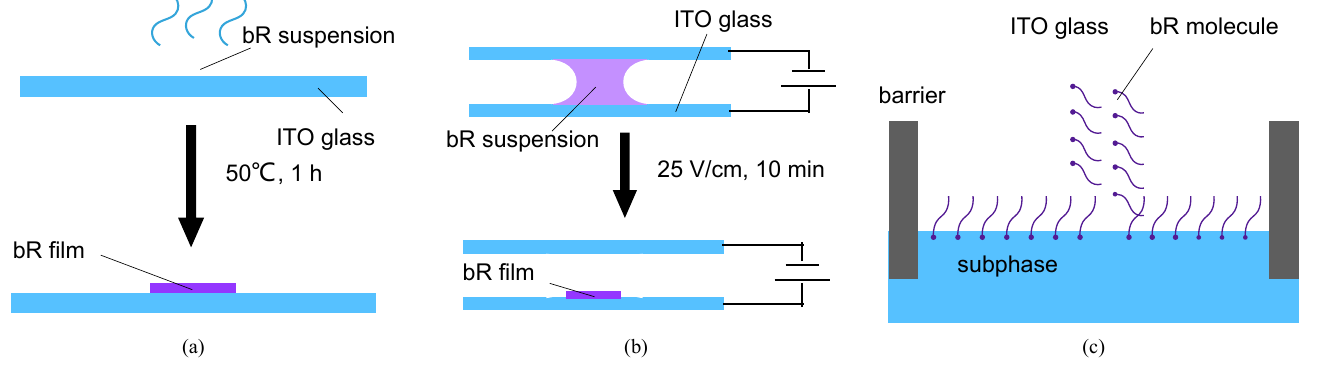
Figure 4. Schematics of the different immobilization techniques. ( a ) Schematics of dropcasting. Evaporation of the solvent leaves a dry bR film on the ITO glass. ( b ) Schematics of electrophoretic sedimentation. The bR molecules move toward the ITO glass under the effect of an electric field, simultaneously forming a unified orientation at the same time. ( c ) Schematics of the Langmuir–Blodgett deposition. The amphiphilicity of the bR molecules leads to an oriented monolayer on the aqueous subphase, which is then transferred onto the ITO glass substrate.